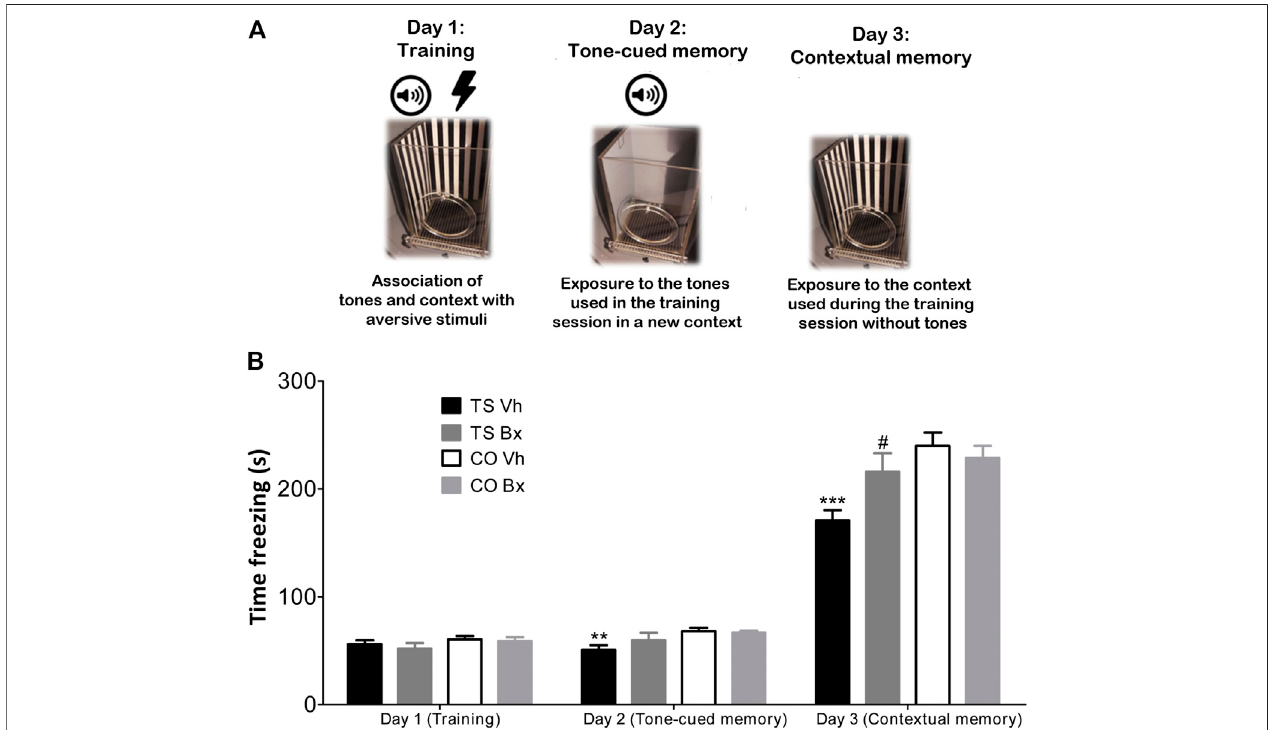
FIGURE 2 | Schematic protocol of the Fear Conditioning Test (A) . Mean ± S.E.M of the time that TS and CO mice under bexarotene or vehicle treatment spent freezingduringthetrainingsession,andinthetone-cuedandthecontextualmemorytestssessionsintheFearConditioningtest (B) .**: p < 0.01;***: p < 0.001 TSVhvs. CO Vh, #: p < 0.05 TS Bx vs. TS Vh; Fisher ’ s LSD post-hoc